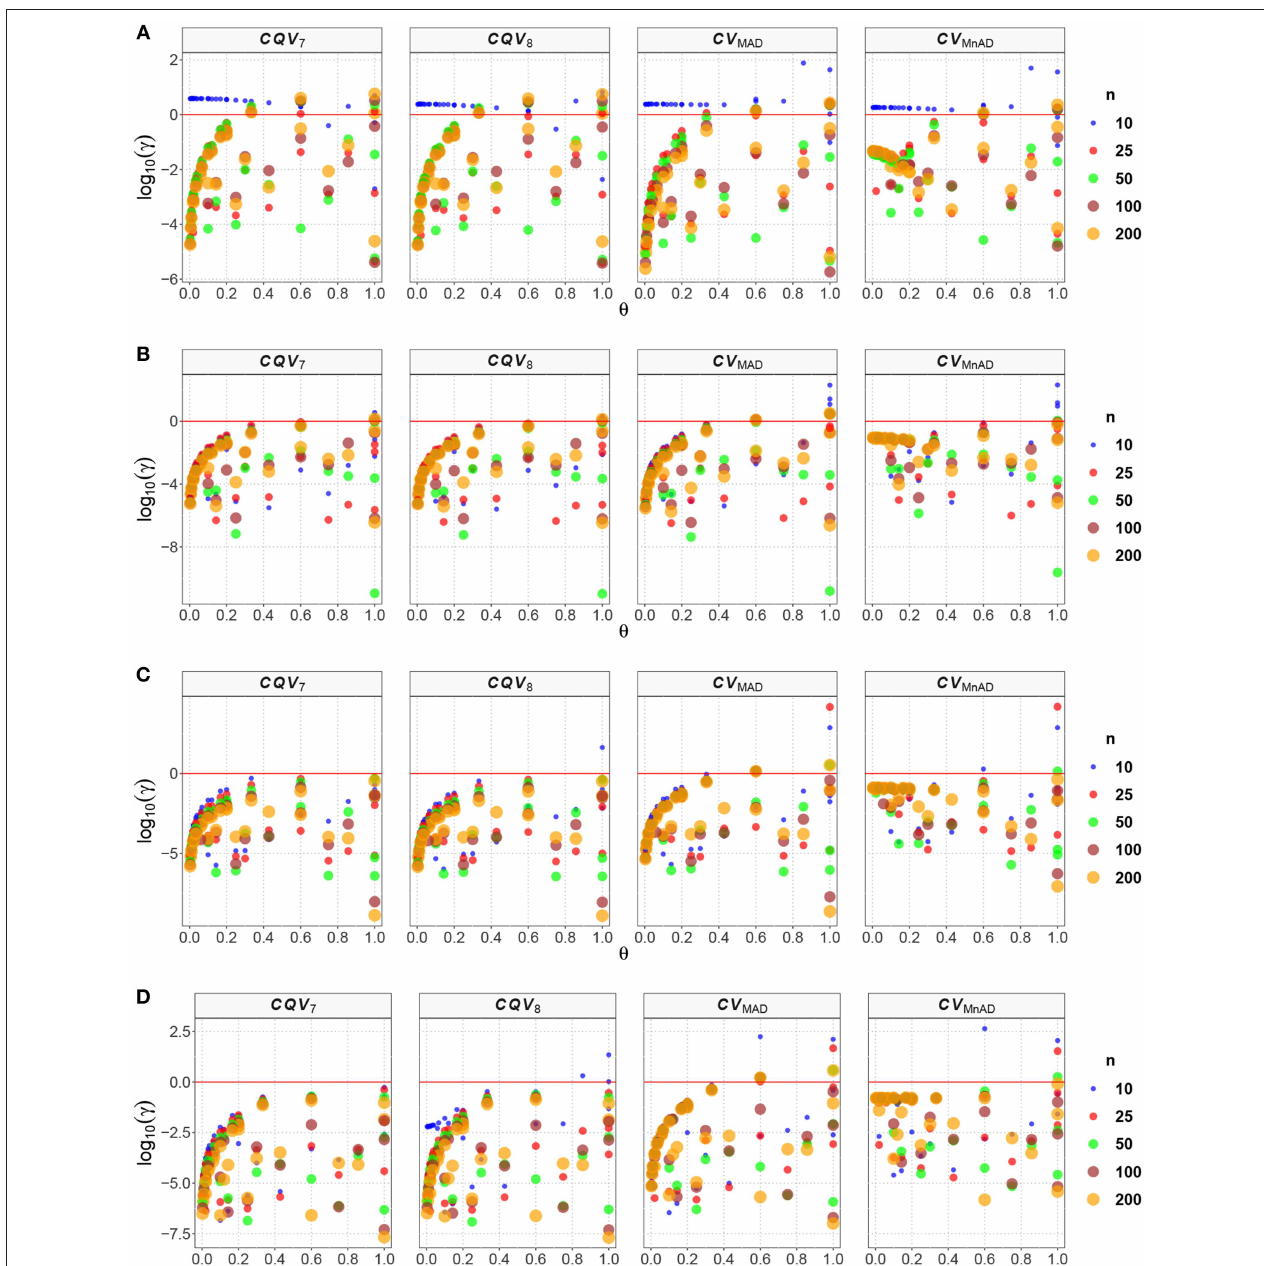
FIGURE 3 | Scatter plots comparing the log 10 ( γ ) accuracy metric as a function of θ normal distribution HN t ( µ , σ , α , ν ) with heavy tails. Each horizontal panel represents a level of contamination, respectively: (A) α and (D) α 20 % . Here, µ , σ , and ν are defined in section Identification of Simulation Scenarios. =